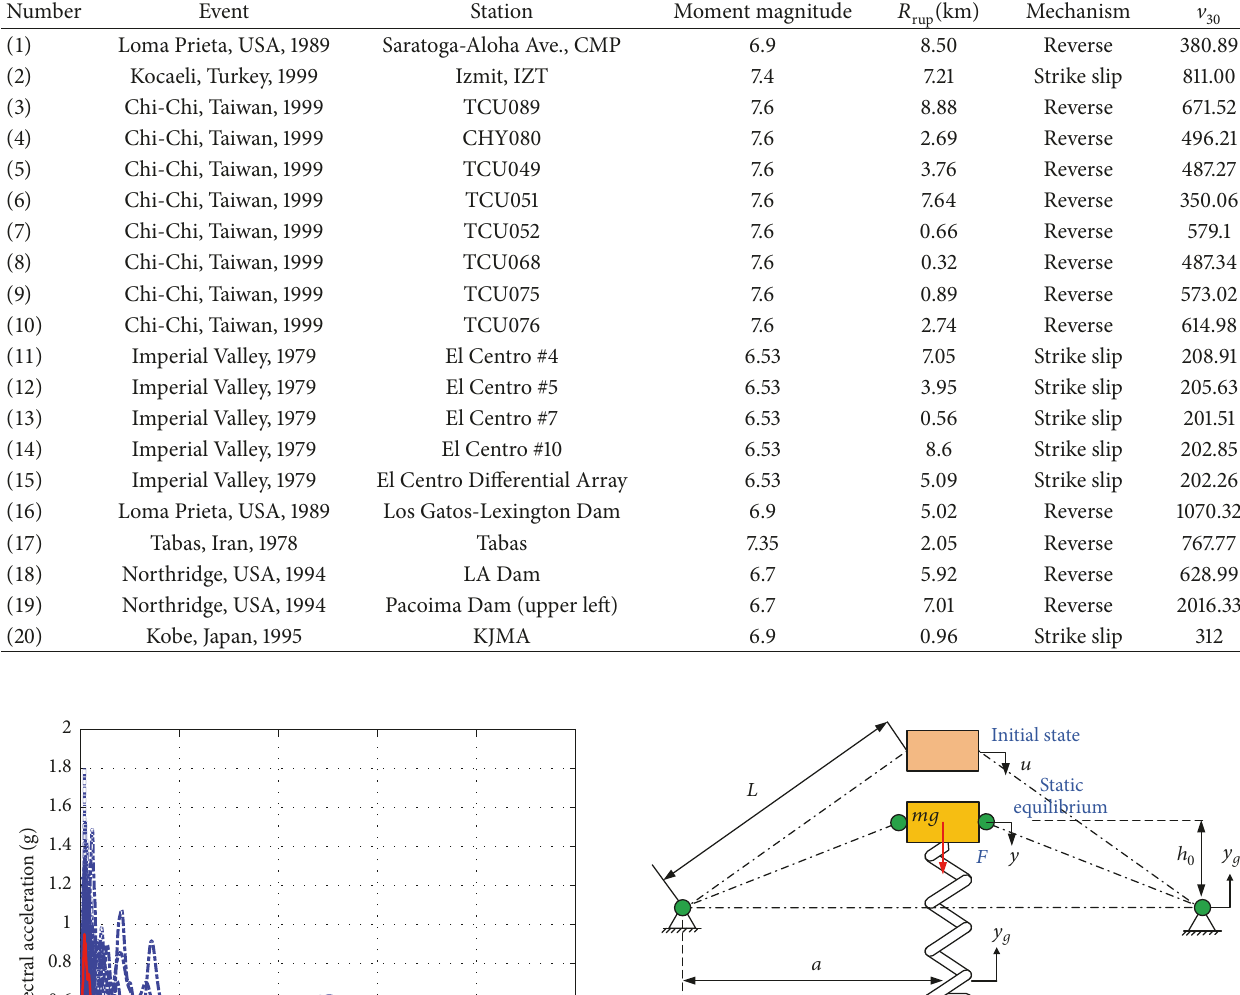
Table 2: Near-fault pulse-like record data.